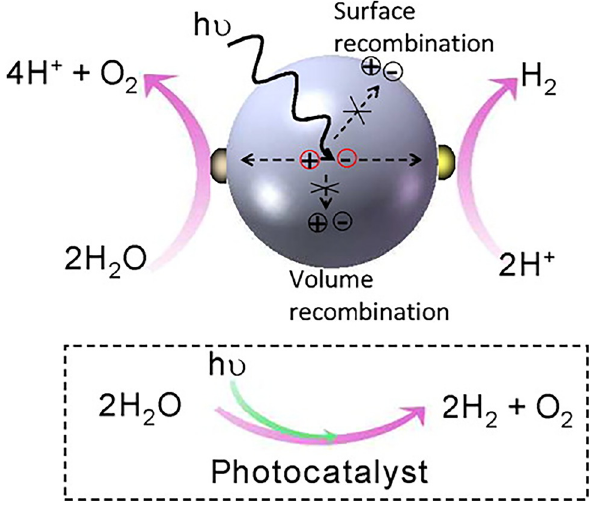
Figure 1: Schematic representation of ( e − / h + ) pairsgenerationupon irradiation of photocatalyst, their subsequent migration to the surface and utilization for H 2 and O 2 production respectively on the surface of cocatalyst. Adapted with permission from the study by Yang et al.